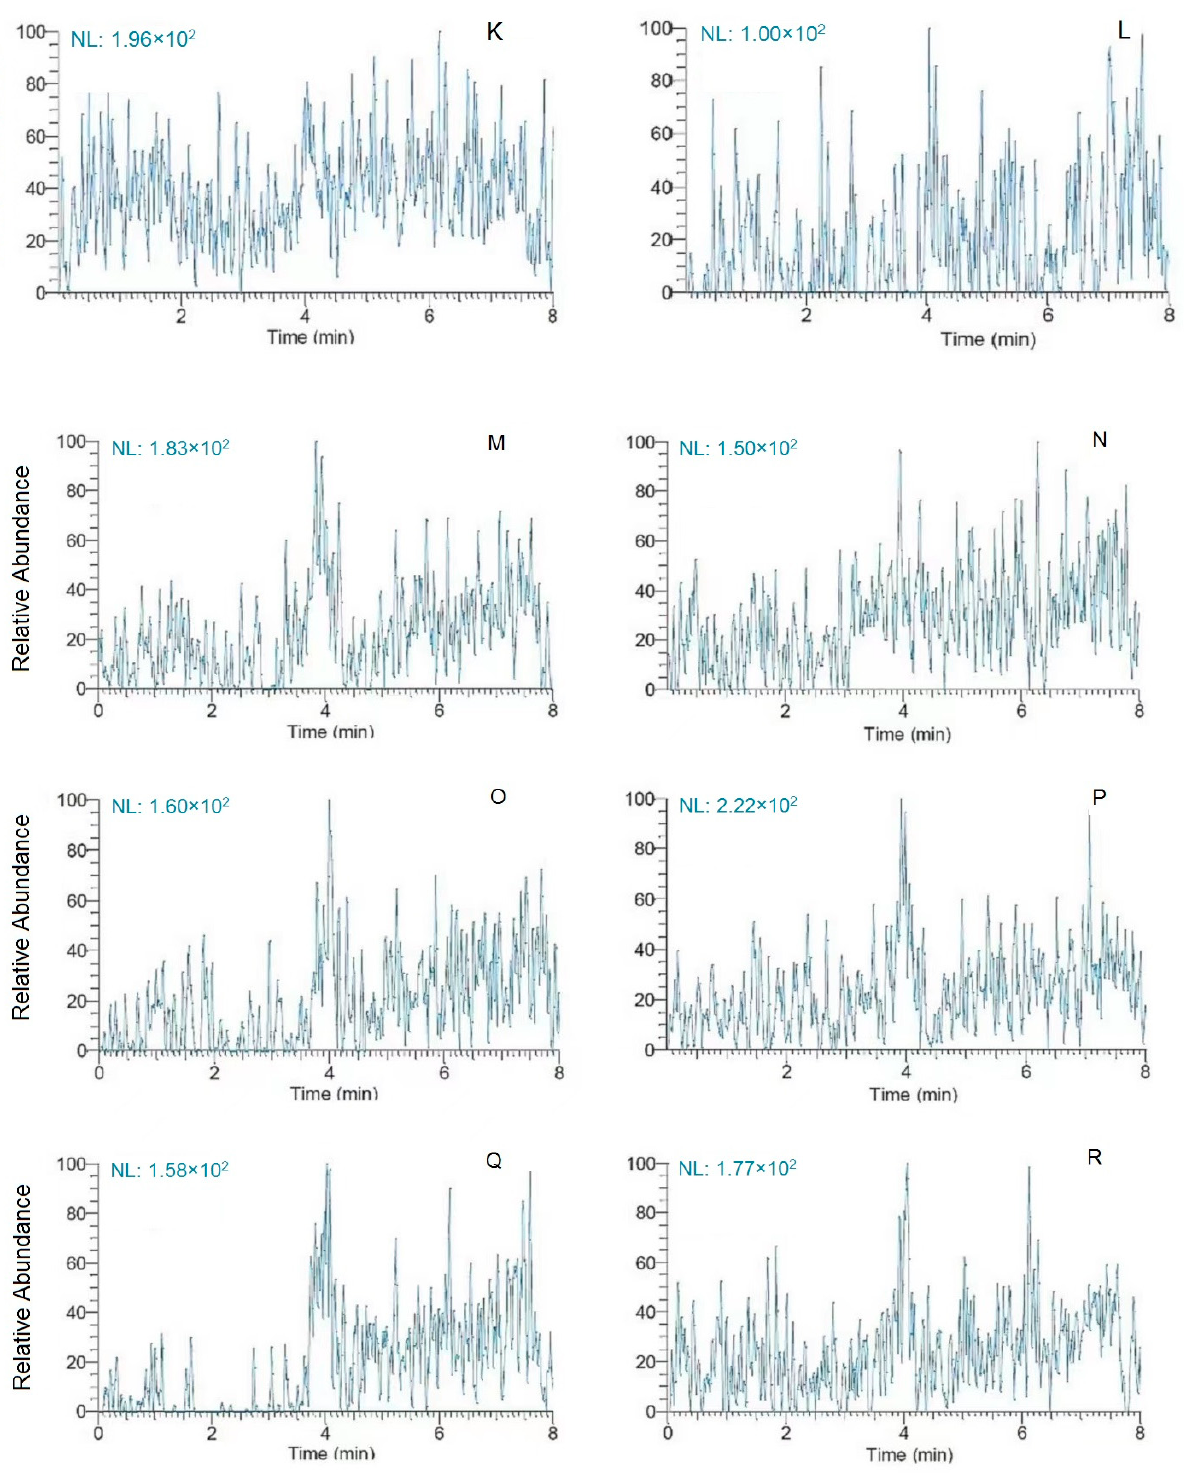
Figure 1. Typical chromatograms of IS-propranolol ( A ), nifedipine ( B ), nitrendipine ( C ), felodipine ( D ), amlodipine ( E ), and nimodipine ( F ) in blank plasma samples, the chromatogram of sixblank plasma samples ( G–N ) and chromatogram of six blank samples after HQC sample analysis ( M – R ).